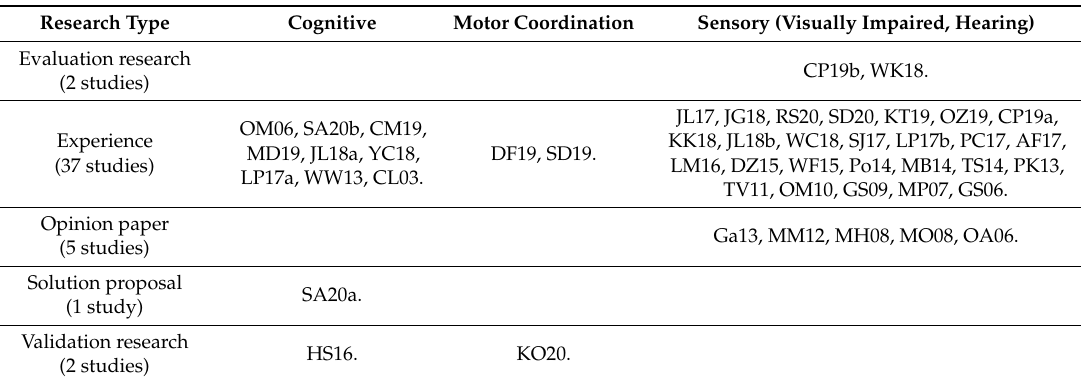
Table 9. Studies according to the type of research by disability.